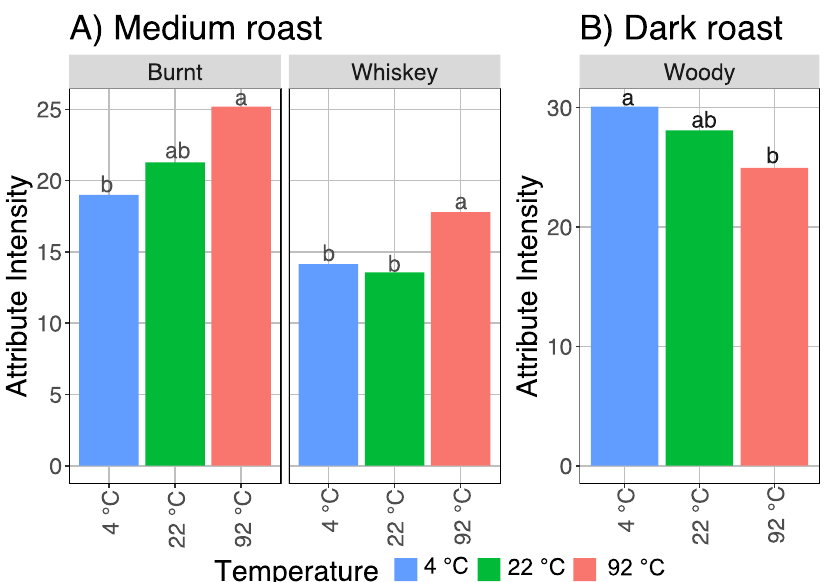
Figure 5. The attributes significantly different by brew temperature for individual roast levels, with LSD letter codes; ( A ) medium roast; ( B ) dark roast.